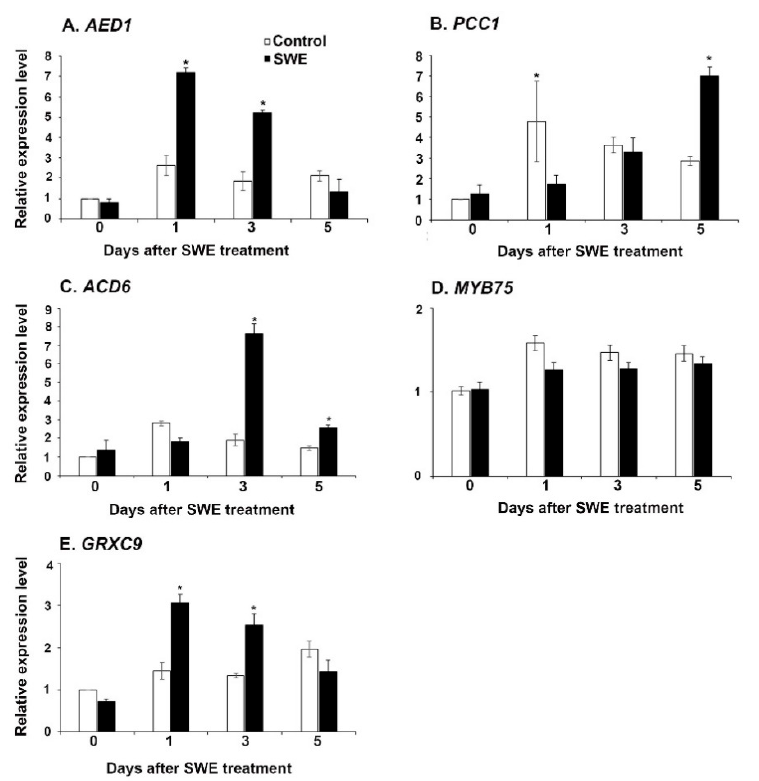
Figure 2. Relative quantification of the expression (fold change) of defence priming-related genes: ( A ) AED1, ( B ) PCC1 ( C ) ACD6 , ( D ) MYB75 , and ( E ) GRXC9 in A. thaliana following a single application of SWE or water as the control. Data shown are the mean of three independent biological replicates (each replicate consisted of 10 plants) and bars represent the standard error of the mean. * denotes significant difference ( p = 0.05) between SWE and control samples at each time point according to Duncan’s multiple range test.